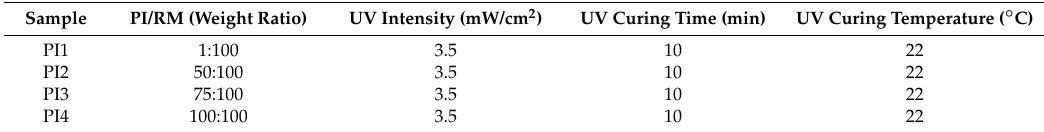
Table 4. With regard to the PI concentration, different concentrations of PI (with respect to the RM) were prepared. In each cell, the weight ratio of RM to LC was kept constant (RM257/ZLI-4792 = 0.3/99.7).